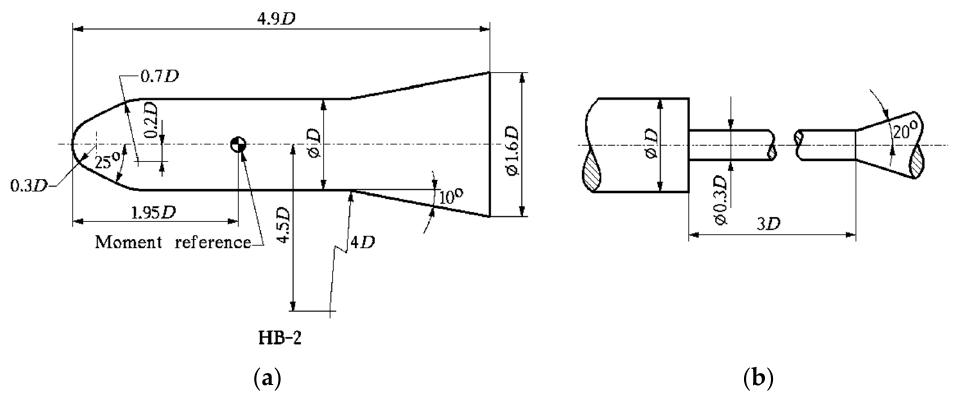
Figure 8. Theoretical geometry ( a ) of the HB-2 standard model, and ( b ) of the standard sting for the HB models [48] based on [40,41].